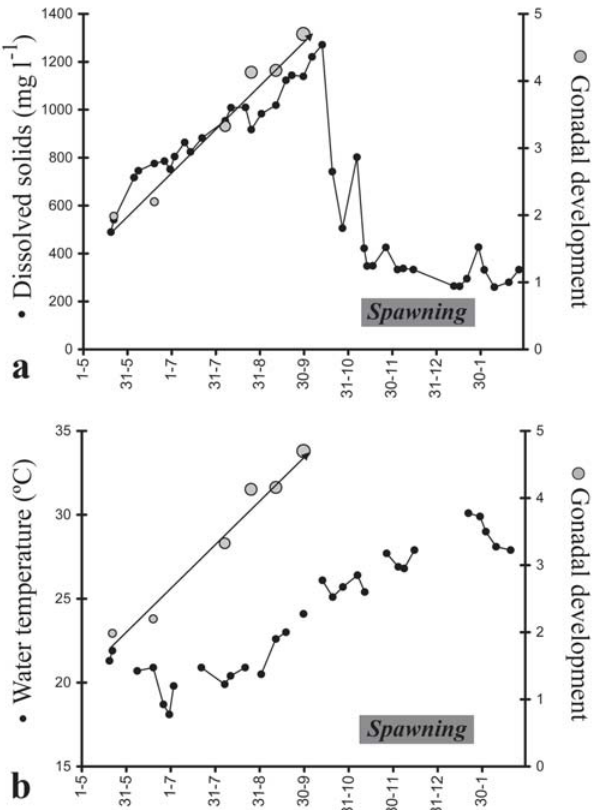
Fig. 3. Total dissolved solids concentration (TDS) in Pilcomayo River water (a) or water temperature (b) and gonadal maturation indices of Sábalo ( Prochilodus lineatus ) fish versus time (May 1998 until February 1999). The gonadal maturation indices are scaled from 1 to 6 in which 6 represents